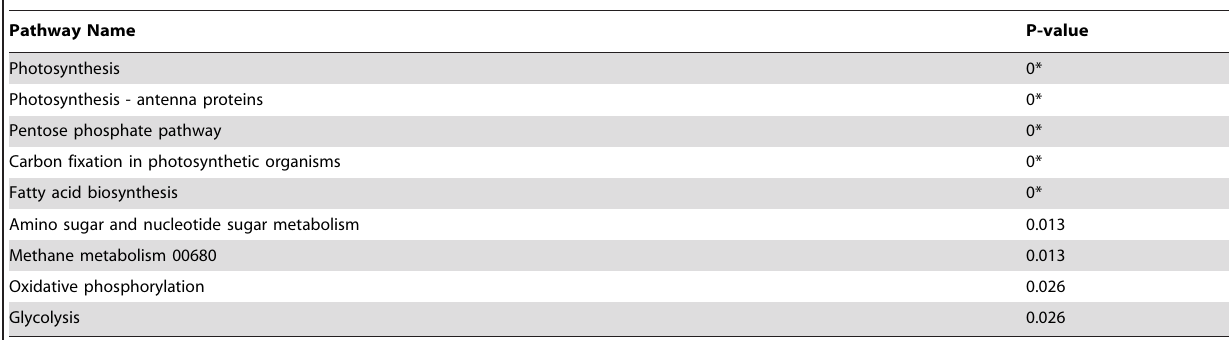
Table 1. Results of GSEA